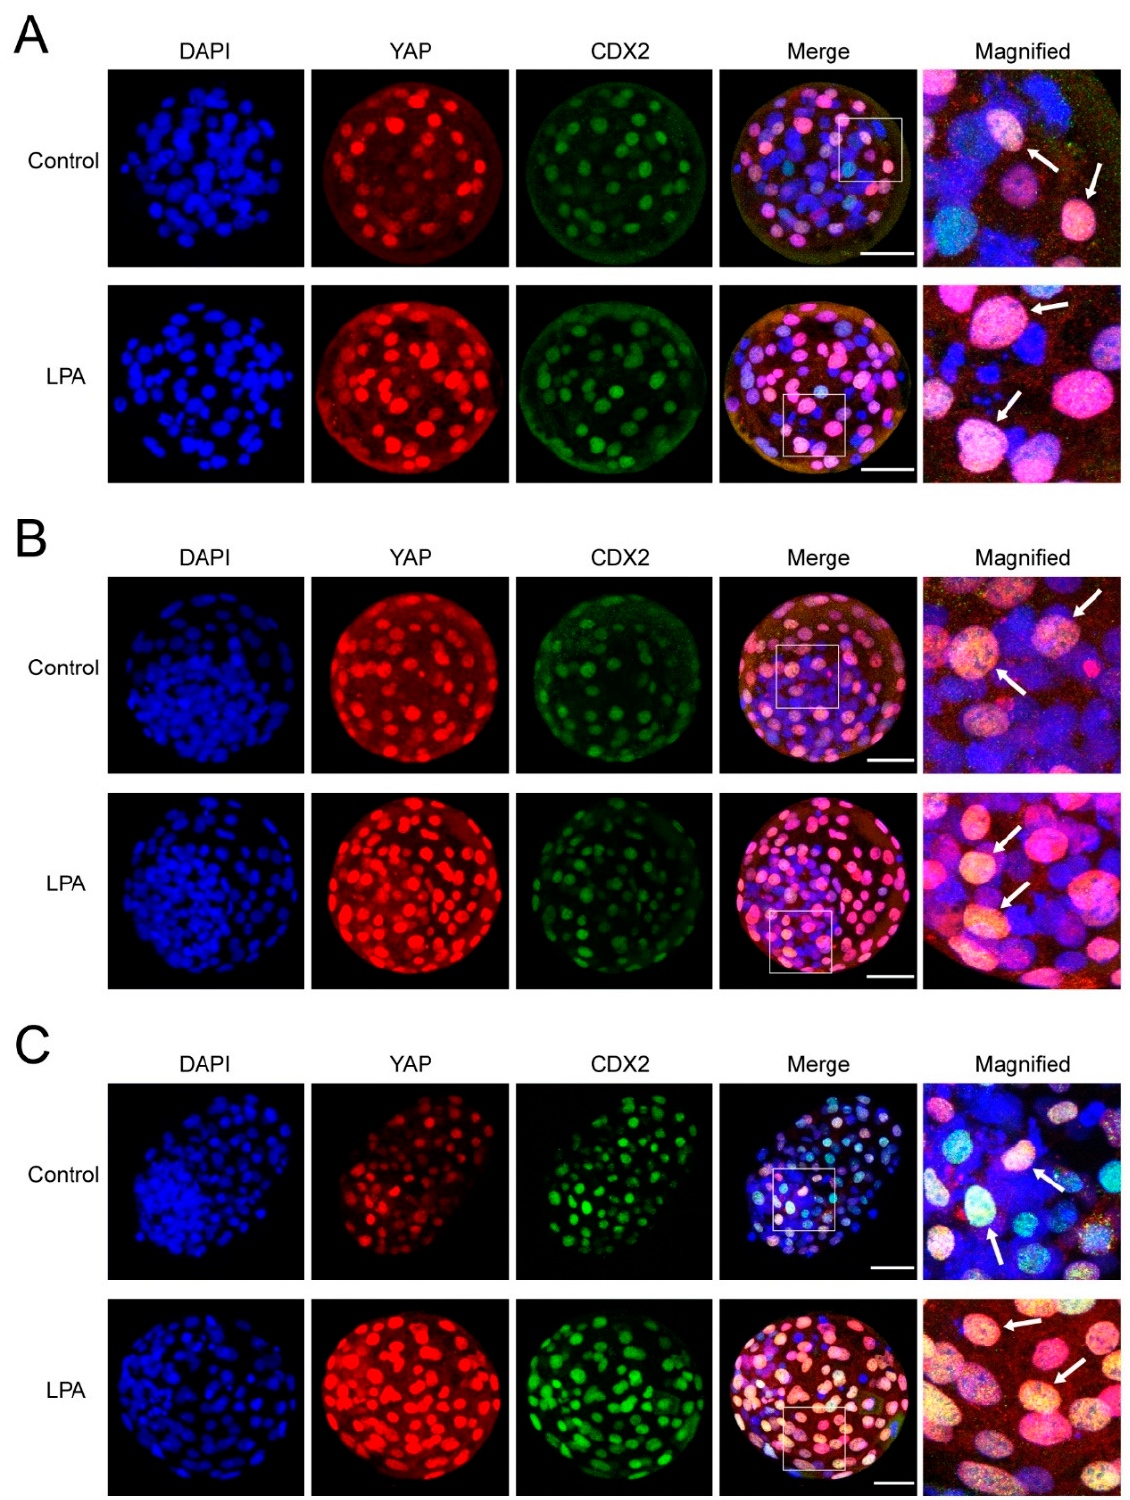
Figure 3. YAP and CDX2 immunofluorescence in bovine embryos cultured in the absence (control) or presence of 10 − 5 M LPA. Day 6 morula ( A ), day 6 blastocyst ( B ) and day 8 blastocyst ( C ). The areas in the white boxes are presented at higher magnification in the right column. YAP and CDX2 colocalization is indicated (arrows). Scale bar = 50 μ m.